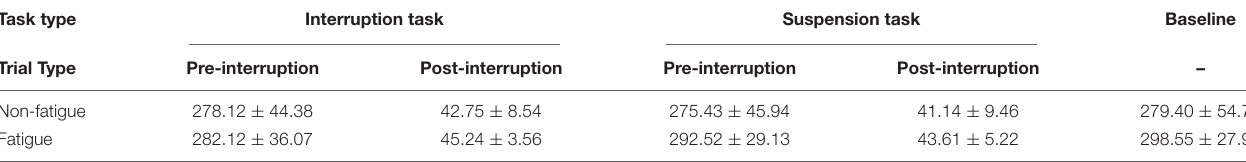
TABLE 1 | Descriptive statistics for the number of trials in each condition (Mean ± SD).